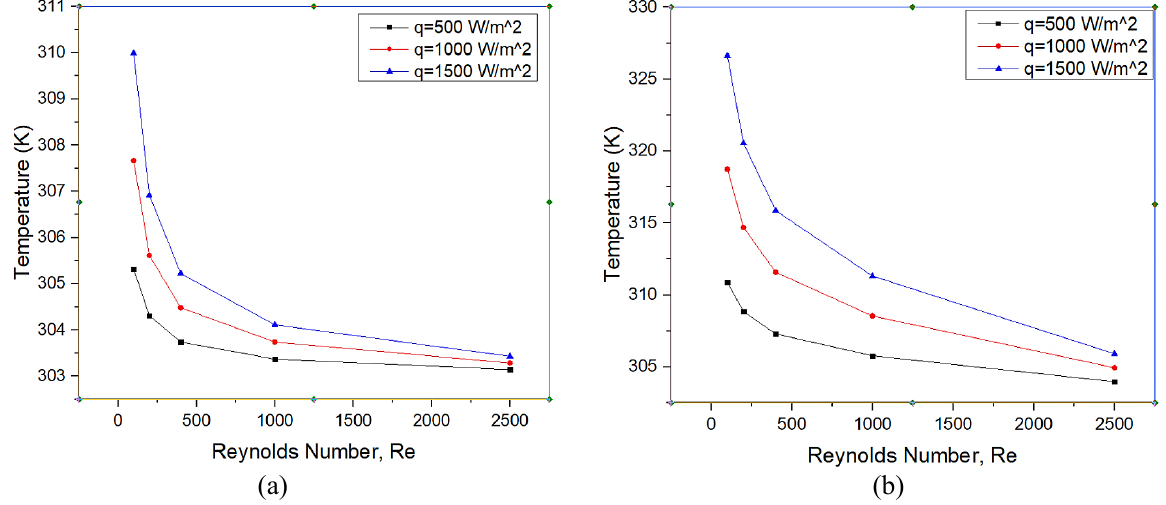
Fig. 4 . Variation of (a) outlet stream temp (b) outlet wall temperature with Reynolds